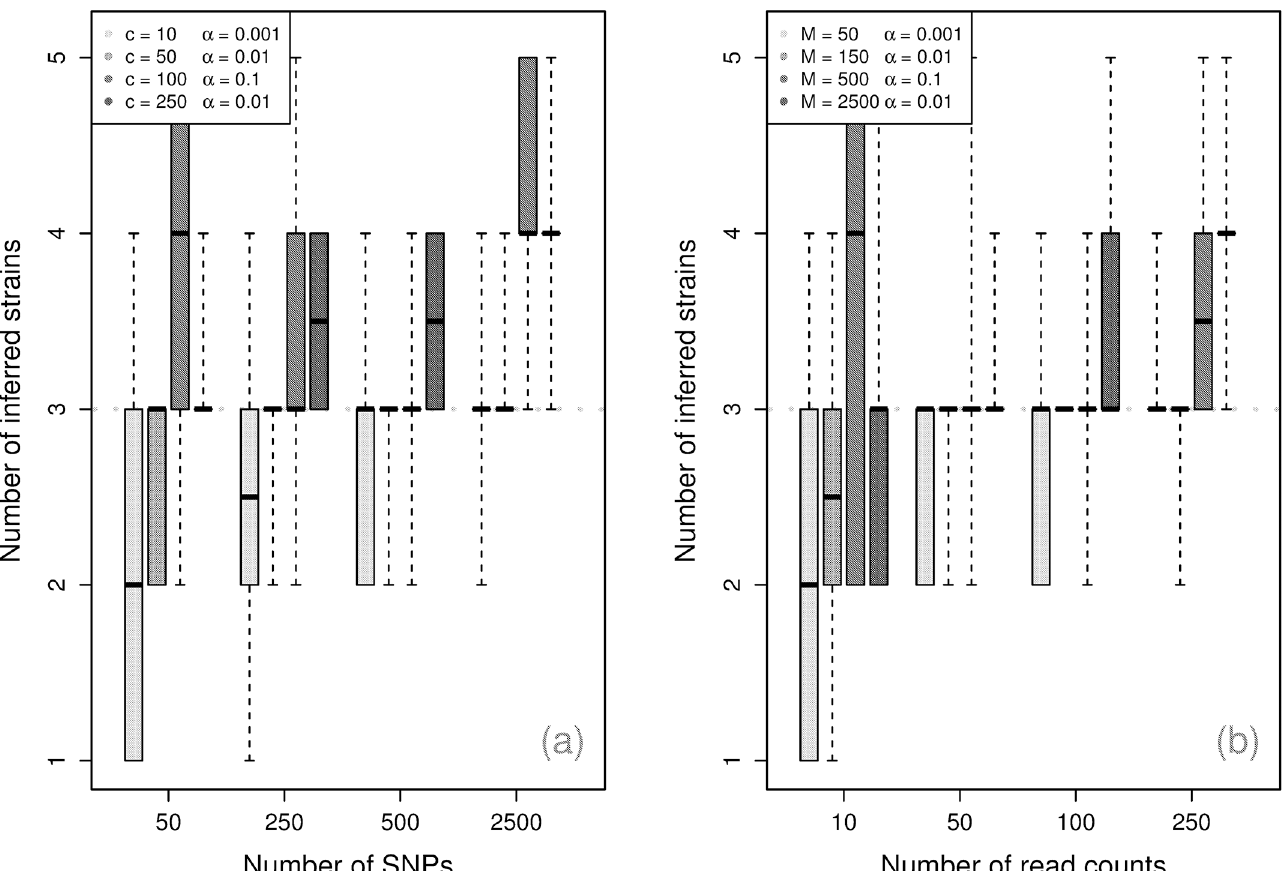
Fig 3. Component inference. Maximum a posteriori (MAP) inferred number of components by number of read counts across 10 simulations, with dotted line at the true number of components.